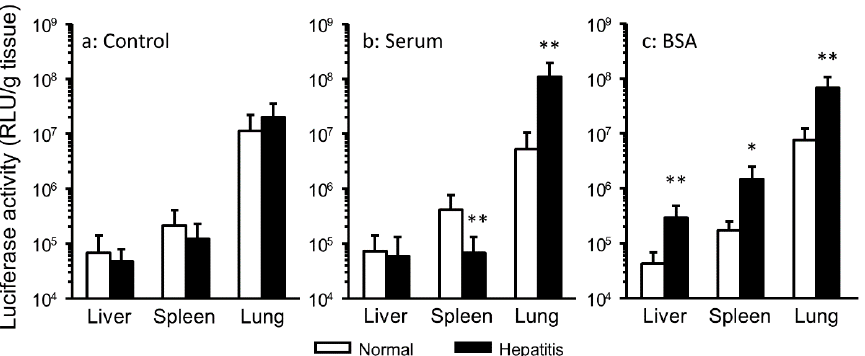
Figure 1. E ff ect of hepatitis on gene expression in each tissue after i.v. injection. Lipoplex was incubated with 5% glucose (control, a ), serum ( b ), or BSA ( c ). Each bar represents the mean + SD of at least 6 experiments. Statistical method, Student’s t -test. * p < 0.05, ** p < 0.01 vs. normal.